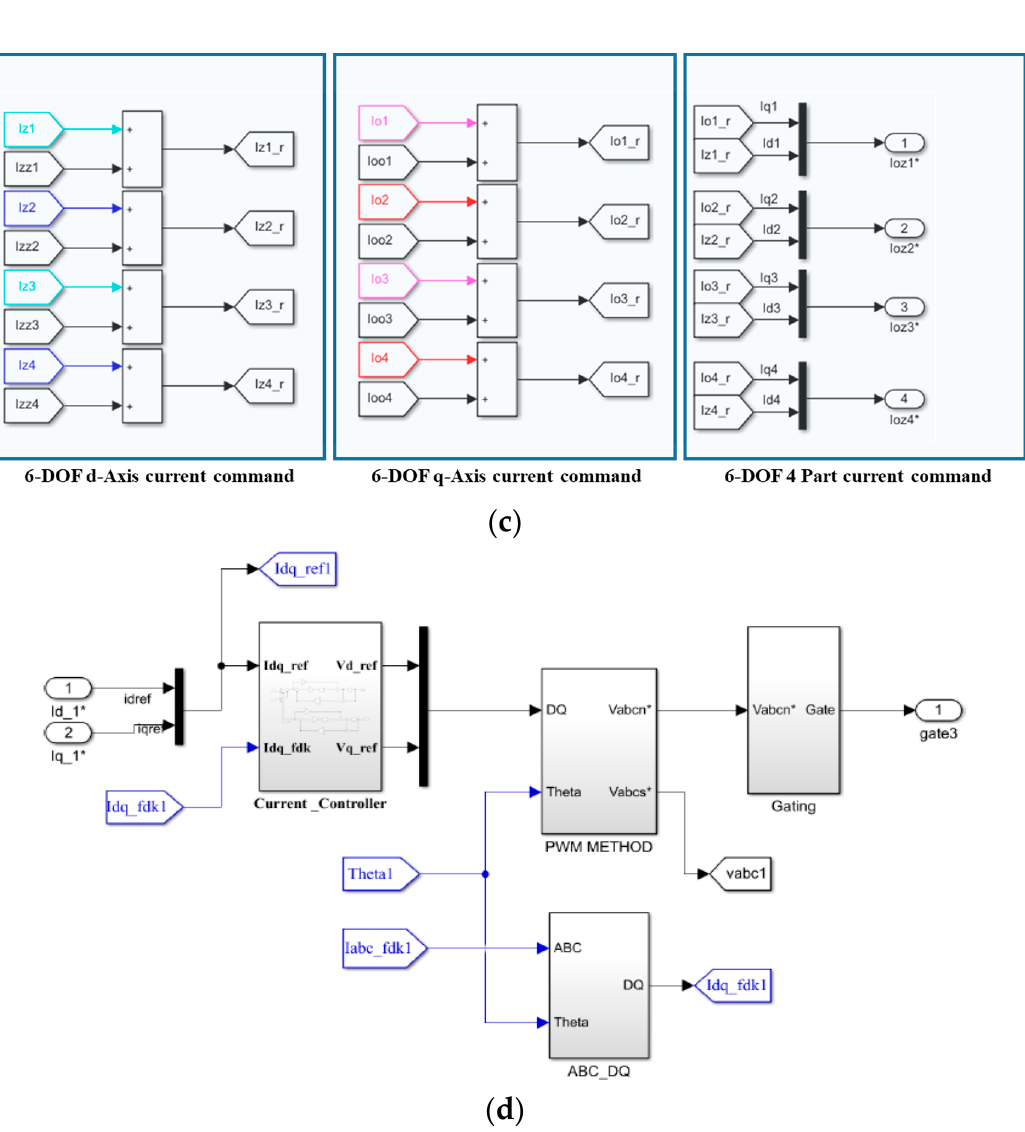
Figure 14. Control simulation modeling of 6-DOF levitation system: ( a ) Simulation modeling; ( b ) Current commands for each part control; ( c ) Distributing the current command of 4 parts of the magnetic ( d ) Current controller (* is command value). Table 1. Six-degrees-of-freedom magnetic levitation system